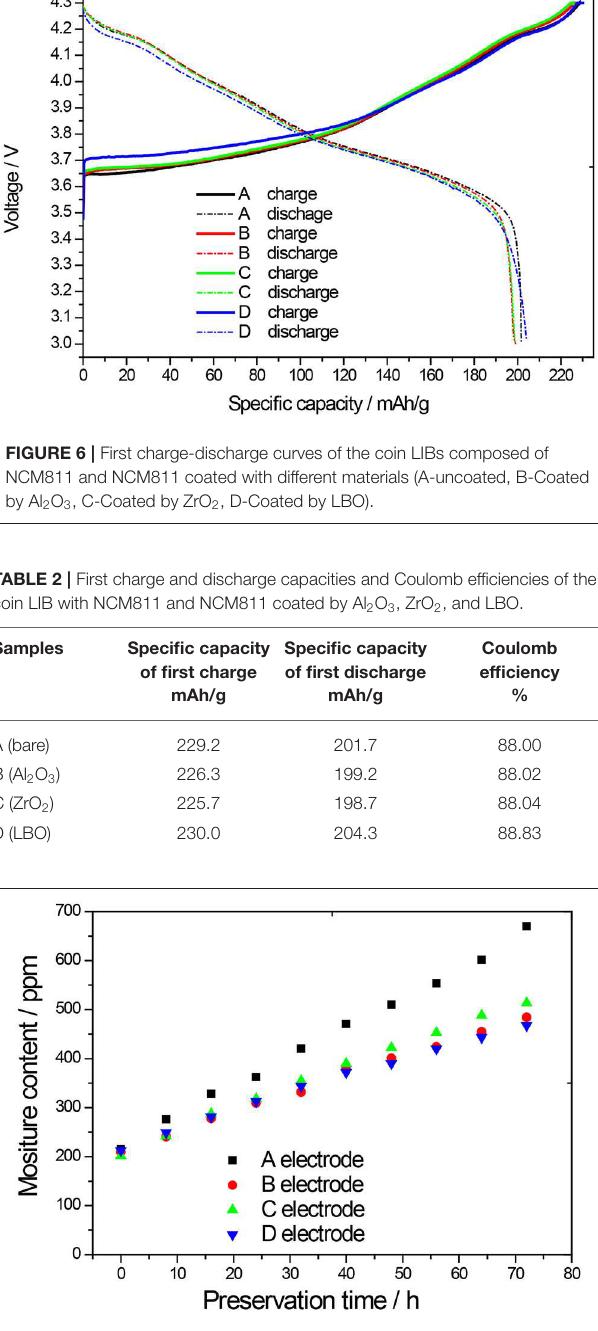
FIGURE 7 | Water value curves of NCM811 cathodes preserved at 25 ◦ C and 10% RH (A-uncoated, B-coated by Al 2 O 3 , C-coated by ZrO 2 , D-coated by LBO).